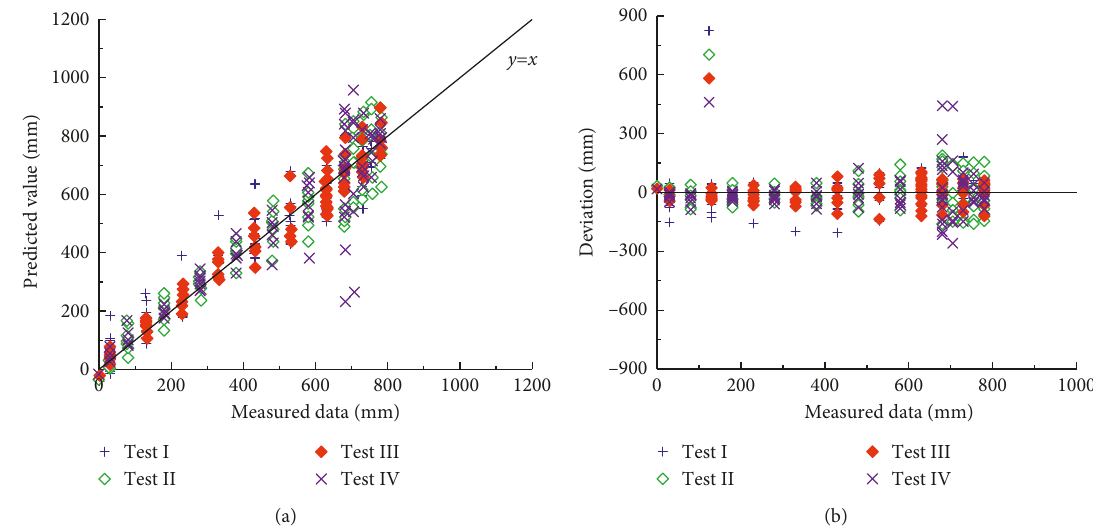
Figure 13: Comparison of predicted and measured curves. (a) Predicted and measured data. (b) Deviation.